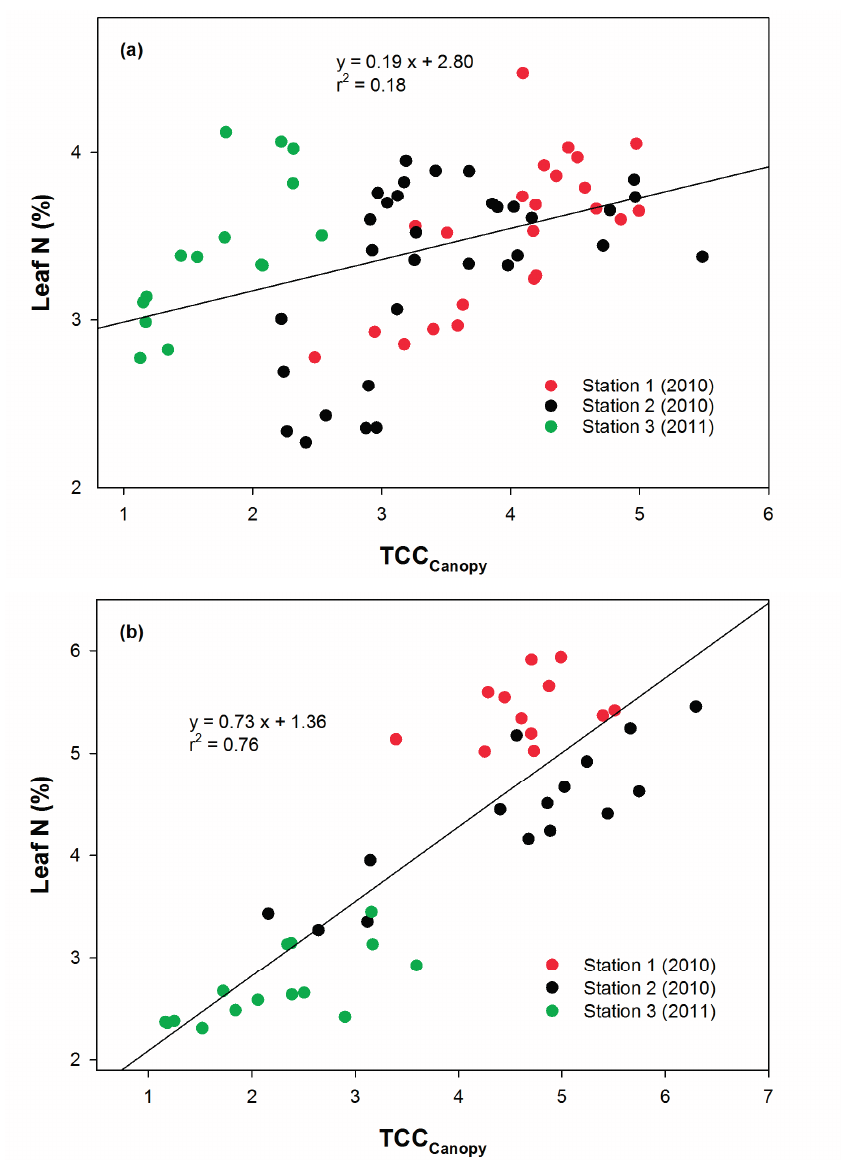
Figure 5. Linear regression between TCC Canopy and leaf N at ( a ) mid to late squaring, and ( b ) early